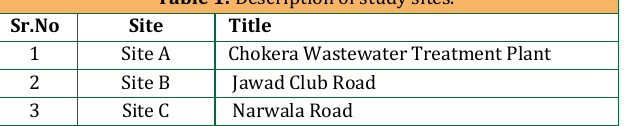
Table 1: Description of study sites.